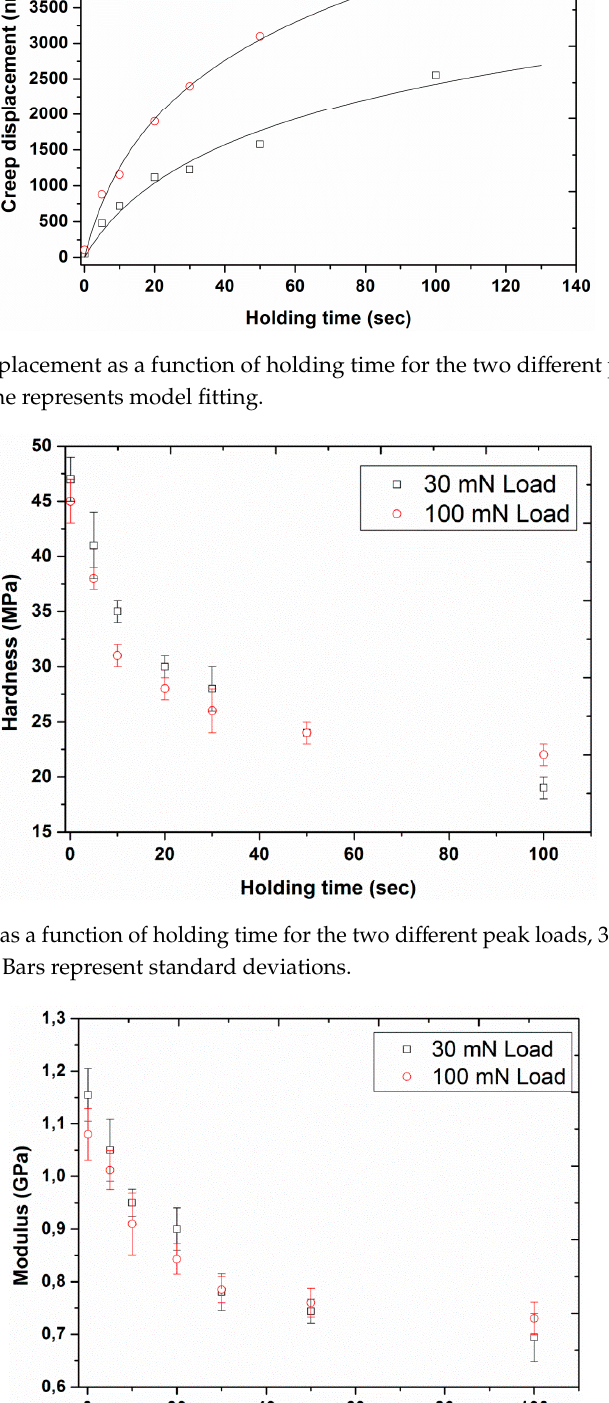
Figure 15. Creep displacement as a function of holding time for the two different peak loads, 30 and 100 mN. The solid line represents model fitting. Table 1. Values of fitting parameters of Equation (1) for UHMWPE.